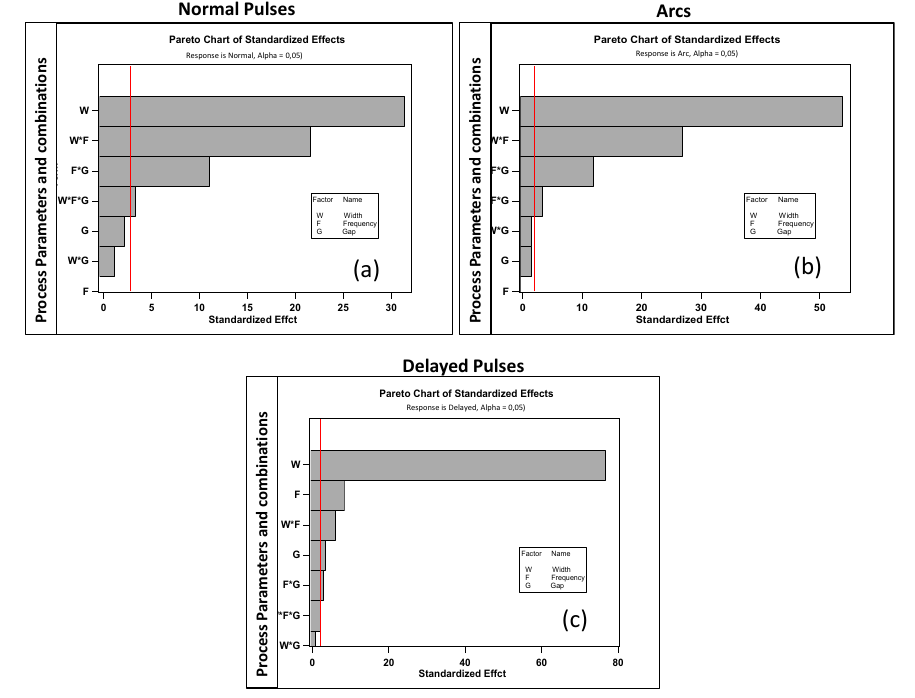
Figure 6. Pareto charts for ( a ) normal, ( b ) arcs, and ( c ) delayed pulses.